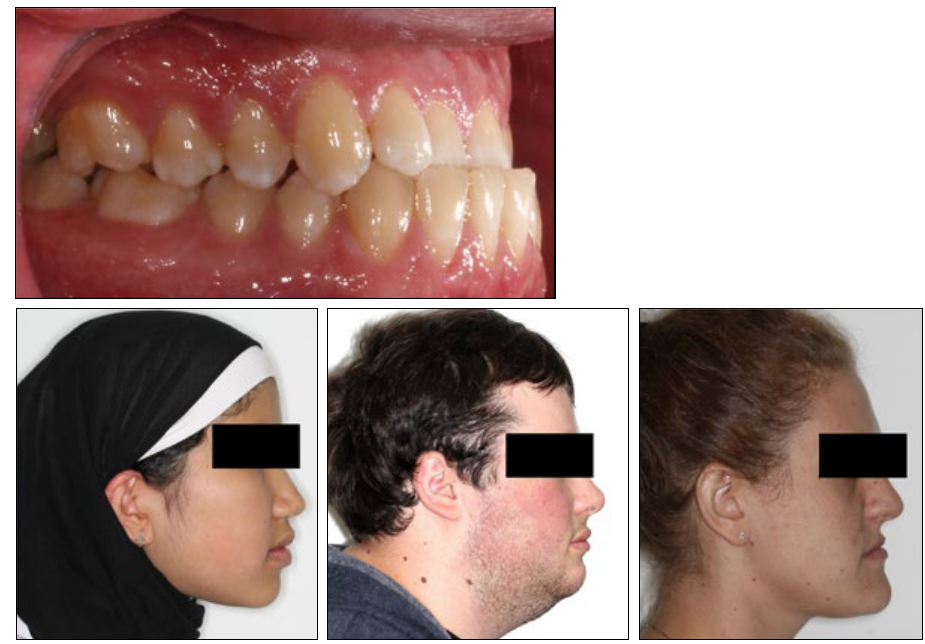
Figure 1. Each of the patients shown above have a reverse overjet of 3 mm but different growth patterns.